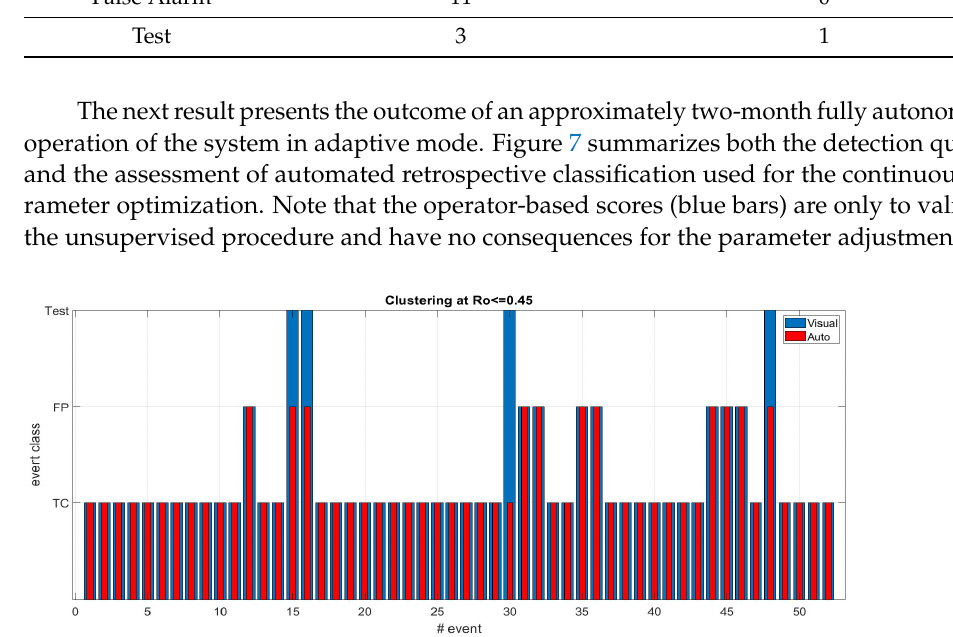
Figure 7. Outcome of fully autonomous system operation including unsupervised adaptive parameter optimization. Vertical axis denotes the event type; horizontal is the number of the event. The blue bars are the operator-validated event types, the red ones are those obtained by the clustering classifier. From 52 events, we have eight false positive detections, four test alerts and 40 tonic-clonic seizures. The algorithm classified correctly all 40 seizures as well as all eight false positives. Three out of the four test events obtained false positive classification, one was classified as a true seizure.